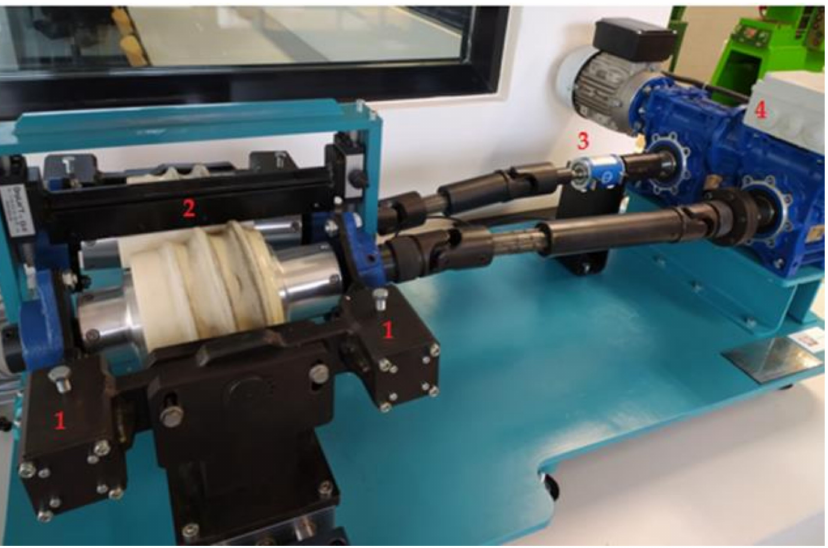
Figure 6. Model skew rolling mill, 1—expansion force sensors, 2—rolling cage, 3—torque sensor, 4—rolling mill drive